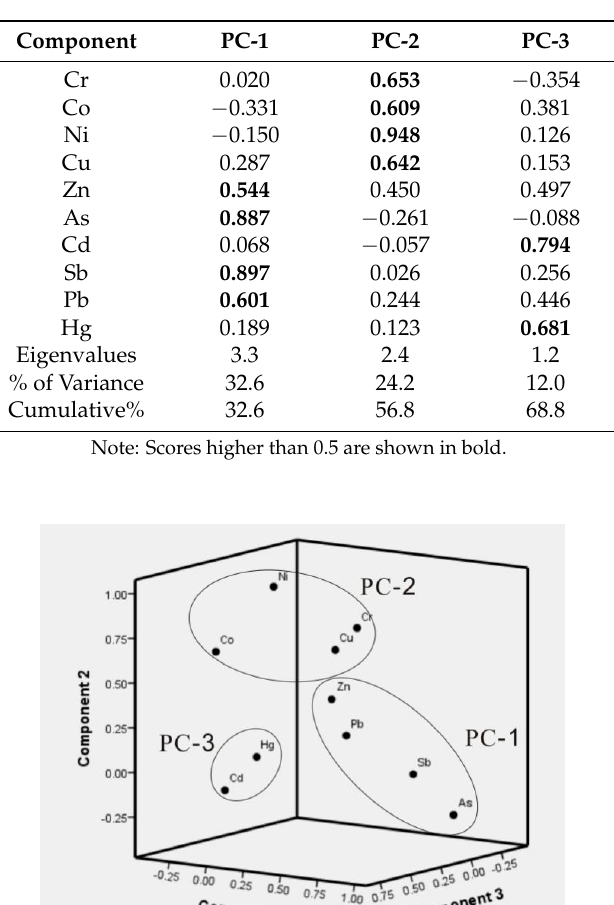
Table 6. Varimax rotated principal components analysis of metal(loid)s in Hezhang city ( n = 30).